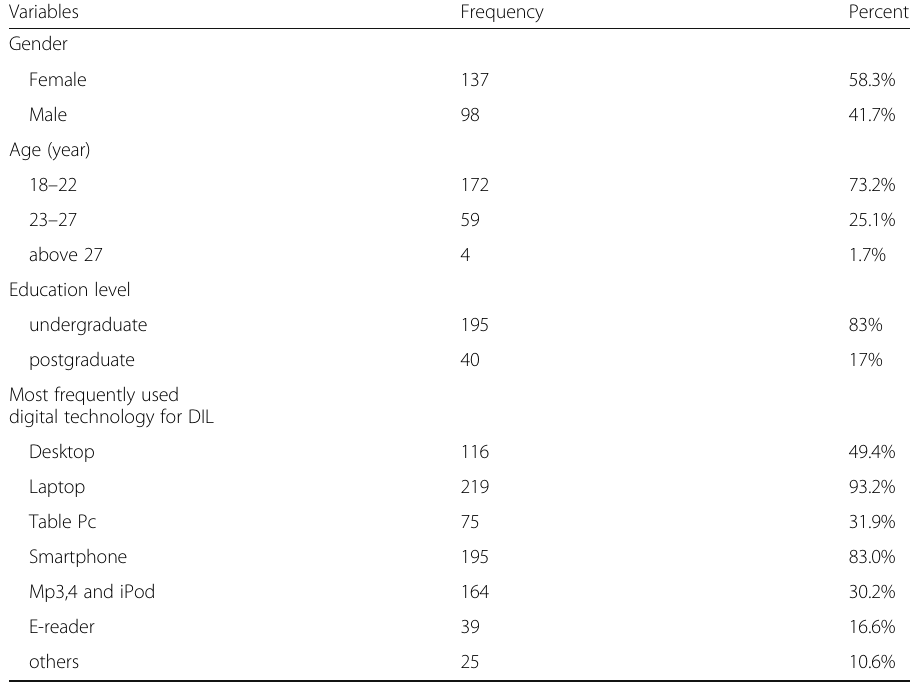
Table 1 Demographic information and descriptive results of